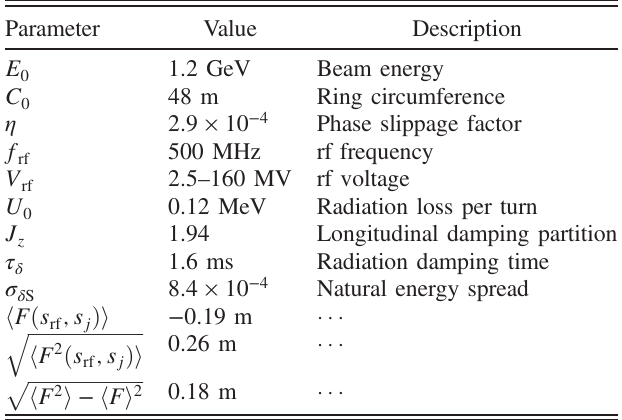
TABLE I. Parameters of the MLS lattice used in simulation.